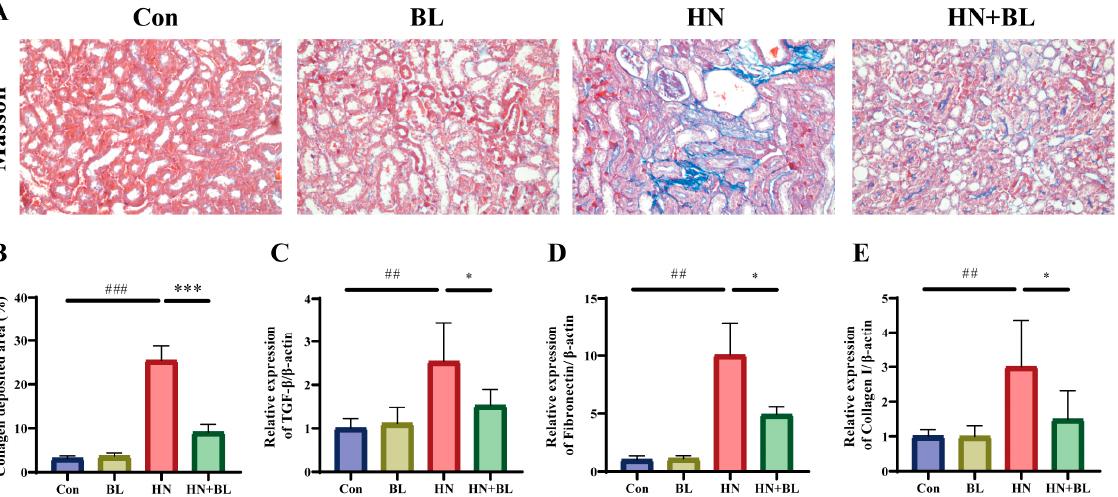
Figure 3. Effect of BL on the renal fibrosis in mice with HN. ( A ,B) The photomicrographs and analysis of the collagen deposition area of Masson’s trichrome staining. ( C – E ) The relative mRNA expression of renal TGF- β 1, Fibronectin and Collagen I. Data represent mean ± SD ( n = 6). ## p < 0.01, ### p < 0.001 vs. the Con group; * p < 0.05, *** p < 0.001 vs. the HN group.